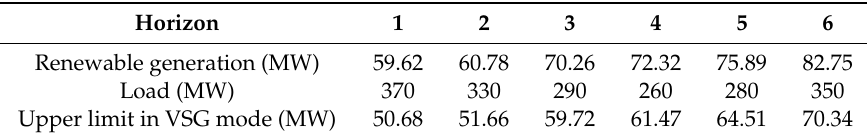
Table 4. Predicted renewable generation and